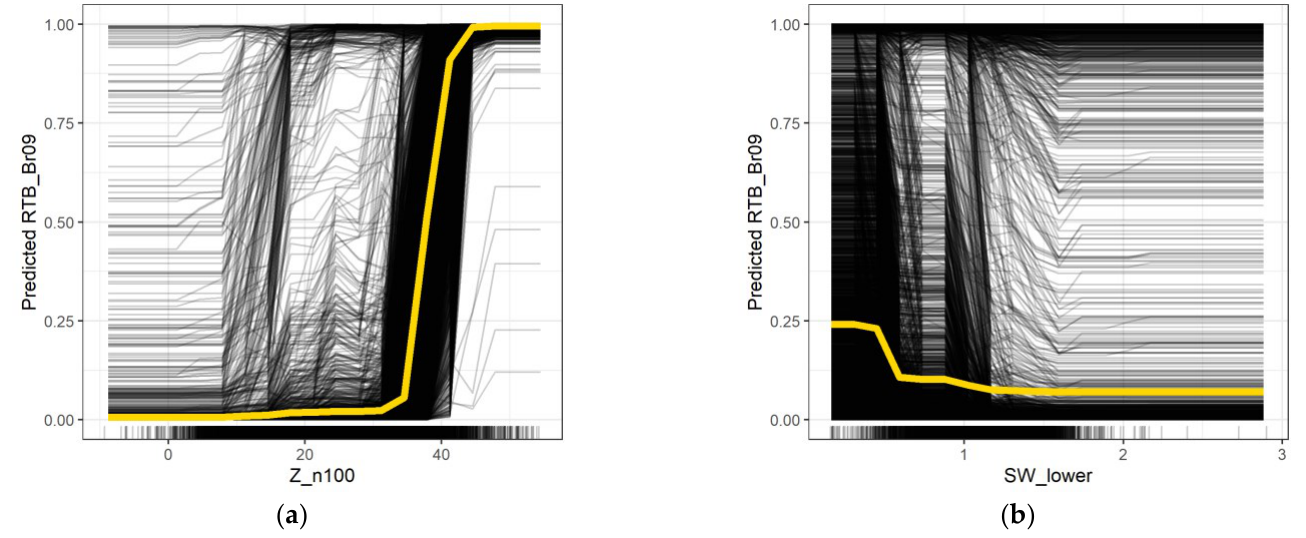
Figure 5. PDPs (yellow) and ICE curves (black) for the features ( a ) Z_n100 and ( b ) SW_lower for a tuned xgboost model on the entire training dataset.